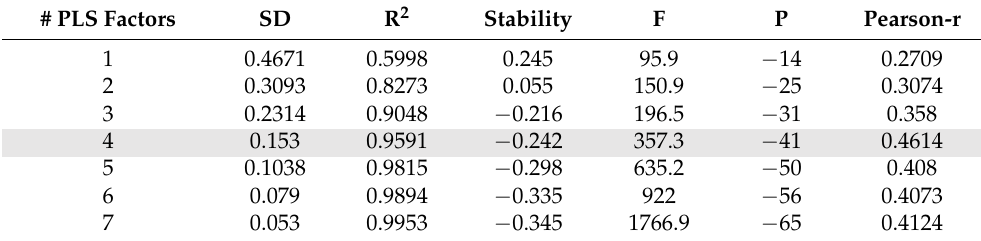
Figure 2. Atom-based QSAR model of anti-preS1 activity. The three dimensional view of the QSAR model illustrates the spatial distribution of contributions to the model. The cubes of the model are colored by the sign of the coefficient: blue for positive coefficients and red for negative coefficients. Positive coefficients indicate an increase in activity, negative coefficients a decrease. Edge length of cubes = 1 Å. Table 2. Statistics of the generated atom-based QSAR model for anti-preS1 activity. Listed are data of a total of seven scenarios with different numbers of partial least squares factors of the regression model (# PLS Factors). SD = standard deviation of the regression; R 2 = coefficient of determination for the regression of the scatter plot of the training set (see Table 1 and Figure 3A); stability = stability of the model predictions to changes in the training set composition with a maximum value of 1 (meaning stable); F = variance ratio (large values of F indicate a more statistically significant regression); P = significance level of variance ratio (smaller values indicate a greater degree of confidence); Pearson-r = value of Pearson-R for the predicted activities of the test set (see Table 4 and Figure 3B). A number of four PLS factors revealed the highest Pearson-r for the prediction of activities of the training set ligands (0.4614) and therefore was chosen as the model for the first VS. # PLS Factors SD R